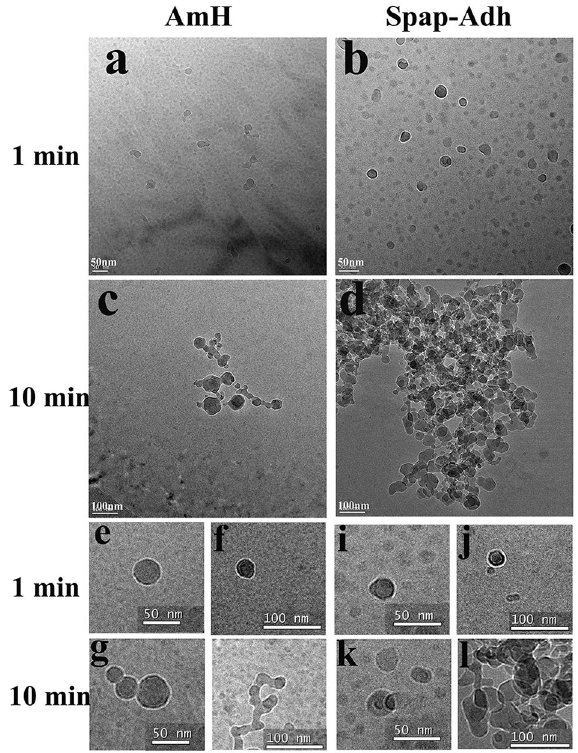
Figure 2. Cryo-TEM micrographs of AmH and Ag I/II; ( a ) AmH at 10 min, full of monmer, dimer and oligomer. ( b ) Ag I/II at 10 min, the tiny particles larger than AmH; ( c ) AmH at 20 min, quaternary